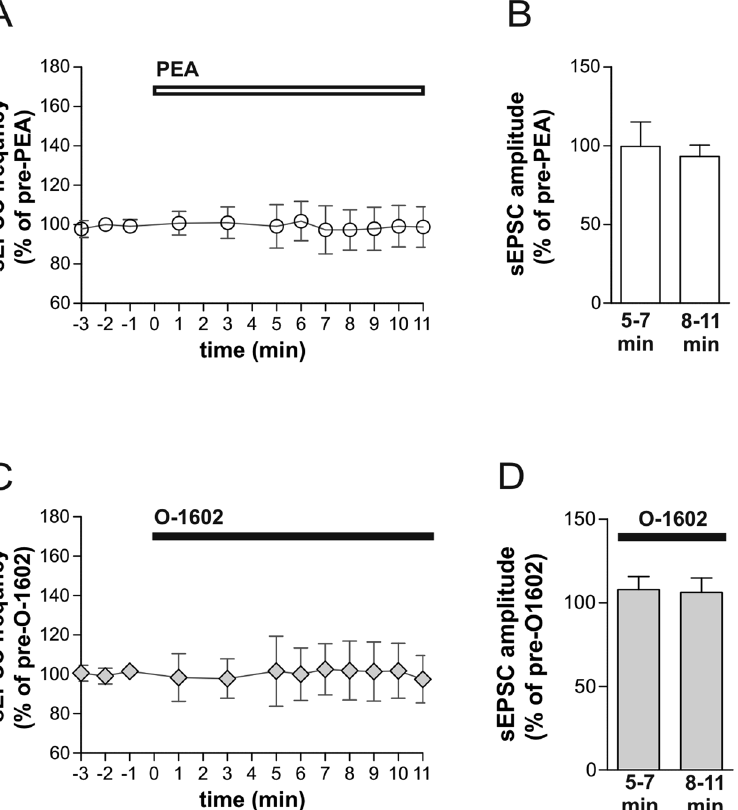
Figure 3. The stimulation of GPR55 receptor fails to alter striatal glutamatergic transmission. ( A,B ) The graphs show that PEA failed to alter the frequency ( A ) and amplitude ( B ) of sEPSCs. ( C , D ) O-1602 also failed to affect glutamatergic transmission in terms of frequency ( C ) and amplitude ( D